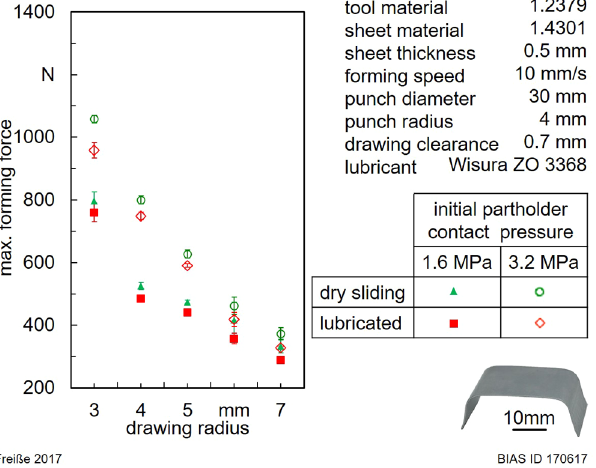
Fig. 14. Maximum forming forces using steel tool under variation of the drawing radius.